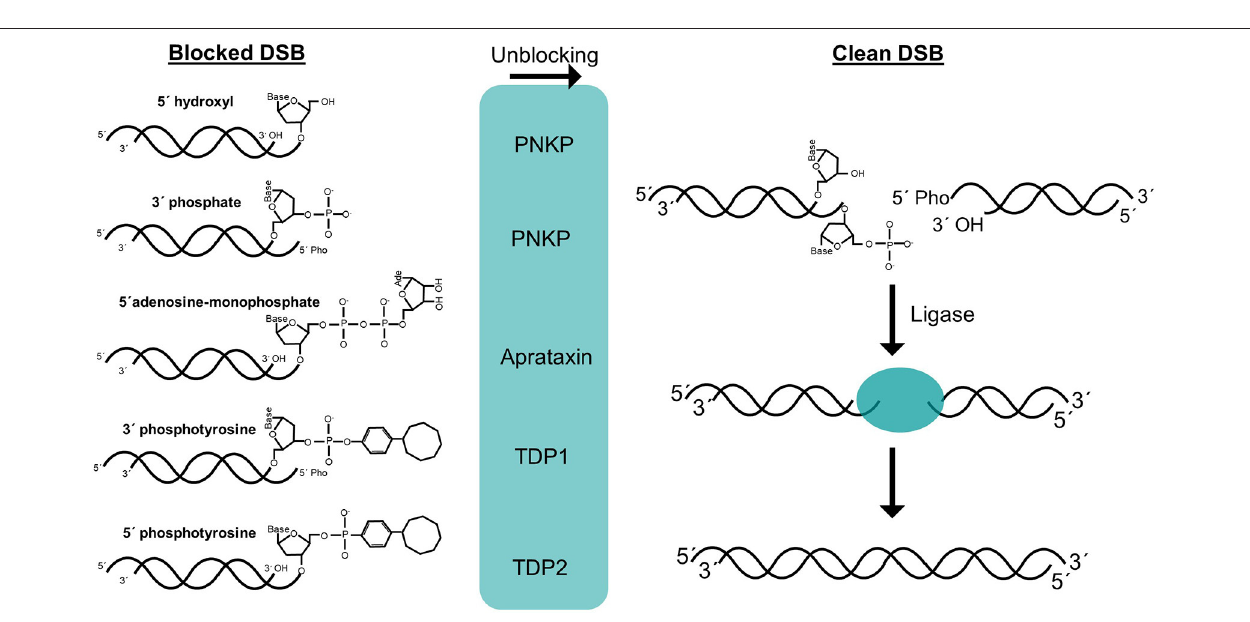
FIGURE 2 | Structure of DNA ends and unblocking enzymes. DSB termini can be blocked by numerous chemical structures in vivo . Several unblocking enzymes are present in mammalian cells and efficiently convert these structures to clean 5 ′ -phosphate and 3 ′ -hydroxyl DSB termini ( left ). These clean DSBs can be in theory, directly repaired with the only enzymatic activity of a ligase ( right